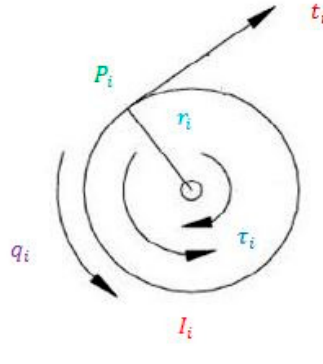
Figure 6. Diagram of an actuator.